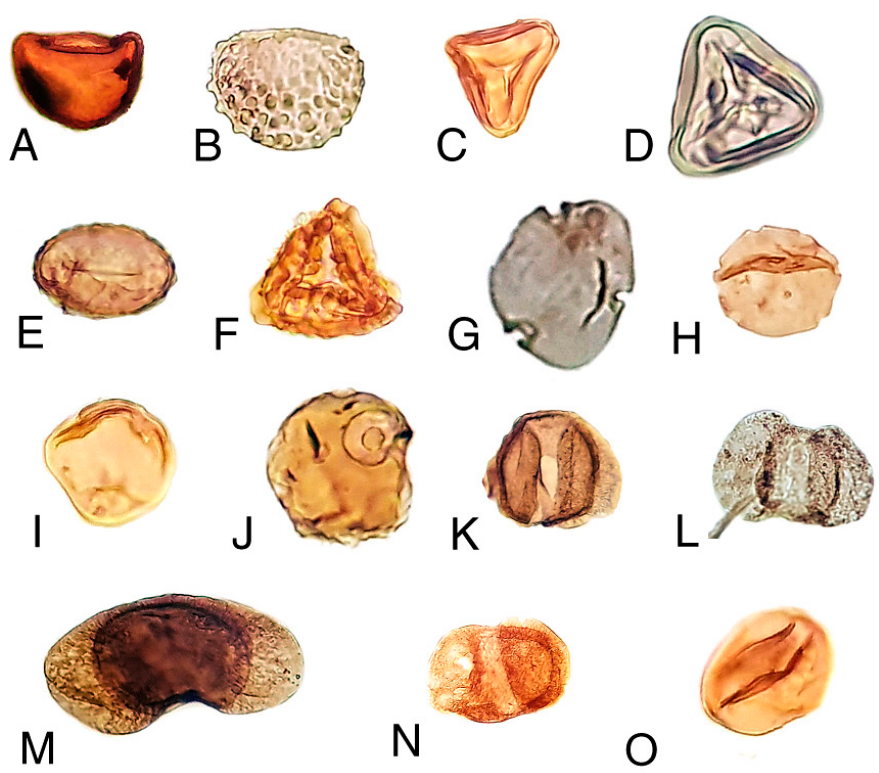
Figure 7. Selected palynomorphs from Miocene marl at Meshgin Shahr site. Spores: ( A ) Unidentified fern spore; ( B ) Lycopodiumsporites ; ( C ) Cyathidites ; ( D ) Polypodiaceosporites ; ( E ) Verruciatosporites ; ( F ) Pteris sp. Angiosperm pollen: ( G ) Malvaceae; ( H ) Pterocarya ; ( I ) Caryapollenites ; ( J ) Graminidites . Gymnosperm pollen: ( K ) Pinuspollenites ; ( L ) Abietinaepollenites ; ( M ) Cedripollenites ; ( N ) Podocarpites ; ( O ) Araucariacites .